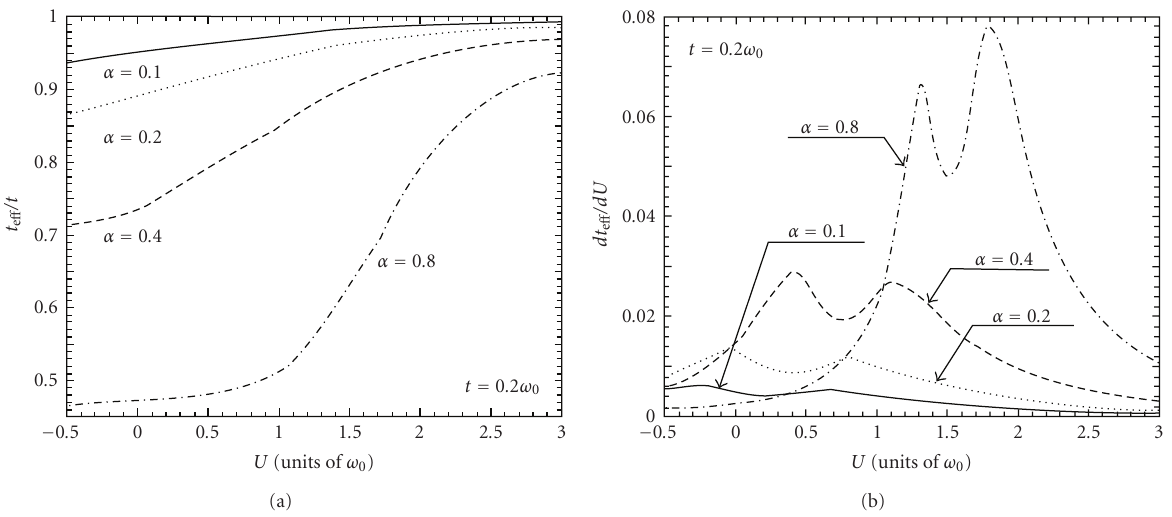
Figure 2: Renormalized hopping integral t e ff and its derivative as a function of U for various values of α at t = 0 . 2 ω 0 .